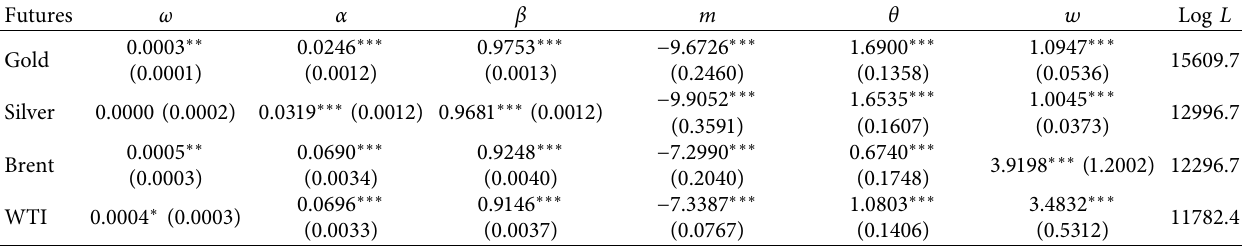
Table 3: Estimation results of GARCH-MIDAS +ID-EMV models of futures volatility by infectious disease with 6-month lags. Futures ω α β